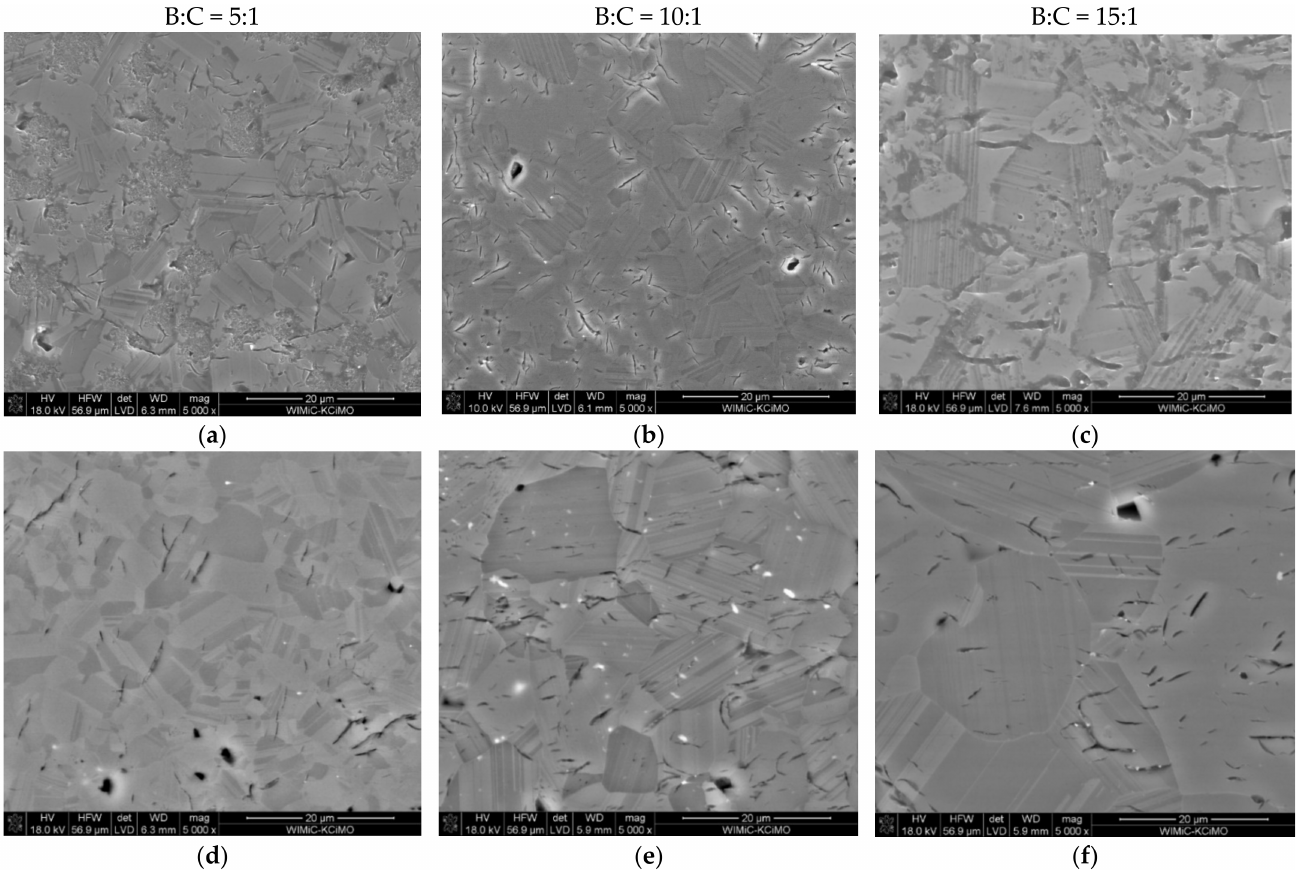
Figure 7. SEM images of boron carbide polycrystals, with different starting compositions, sintered at: 1850 ( a – c ) and 1900 ◦ C ( d – f